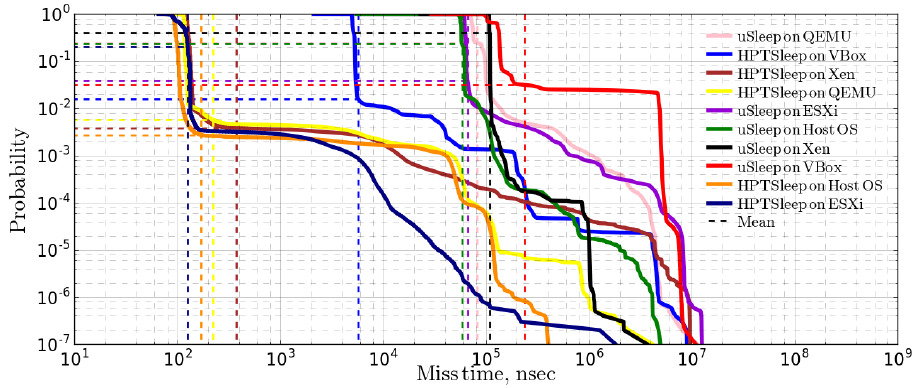
Figure 15. CCDF representation of measurements of miss time for the IO/network testbed.